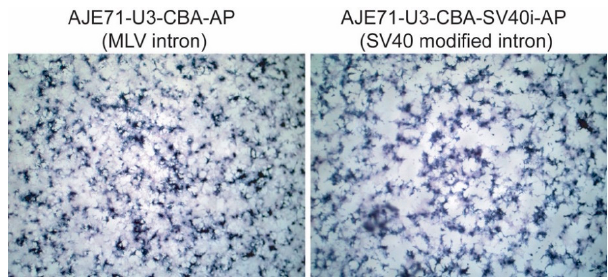
Figure 7. Transfection of two different plasmids in HEK 293 cells, utilizing different